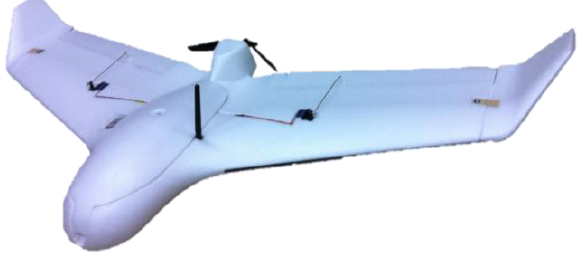
Figure 1. “Flying Wing” airframe implemented